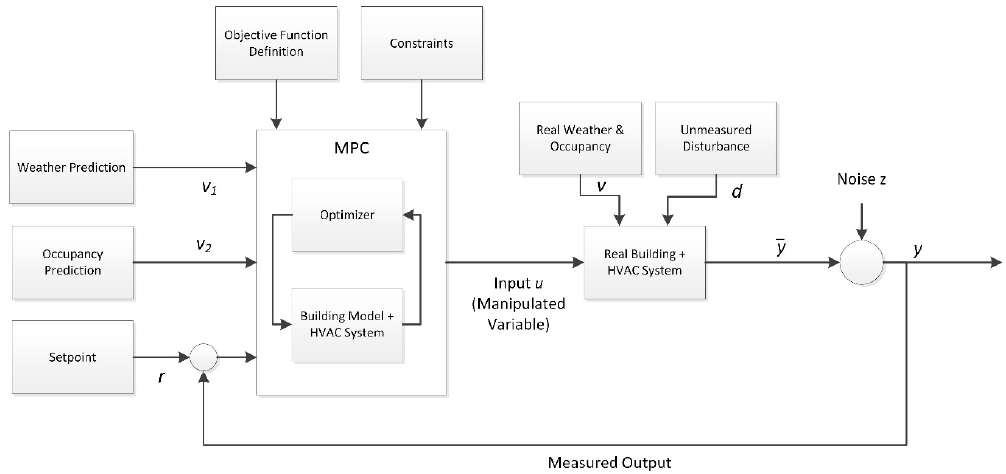
Figure 4. MPC formulation schema for the decentral residential energy system problem.